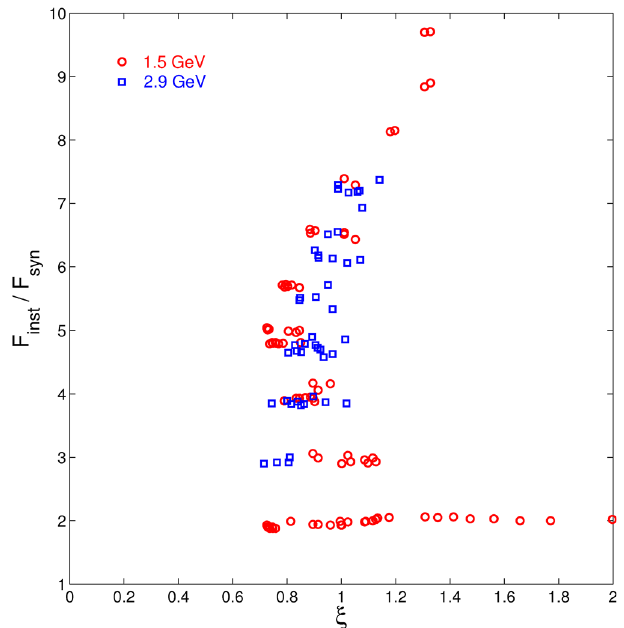
FIG. 10. Normalized instability frequencies at 2.9 and 1.5 GeV as a function of the dimensionless parameter ξ as defined by Cai [10] and Eq. (12) in the text. The data generally fall within the interval ξ ≈ 0 . 7 – 1 . 0 in marked contrast to the threshold value ξ ¼ 0 . 50 as predicted when shielding of the CSR impedance is thr ignored. Note the tendency to curve to the right with increasing mode number, equivalent here to increasing bunch